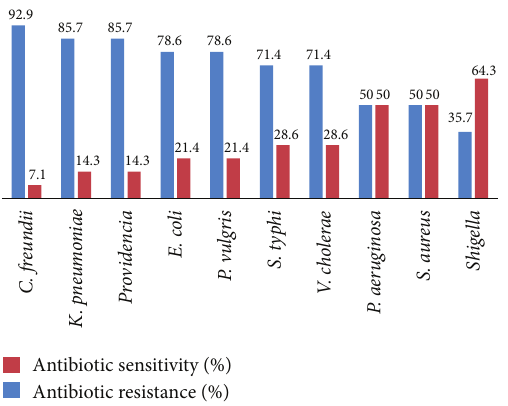
Figure 1: Percentage of antibiotic resistance and sensitivity of MDR bacterial